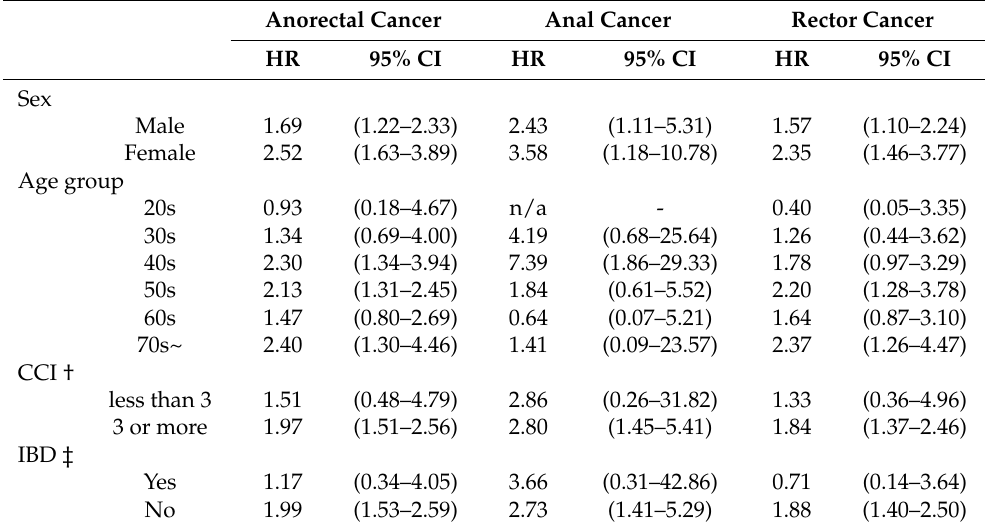
Table 3. Subgroup analyses on anorectal caner, anal cancer, and rector cancer.